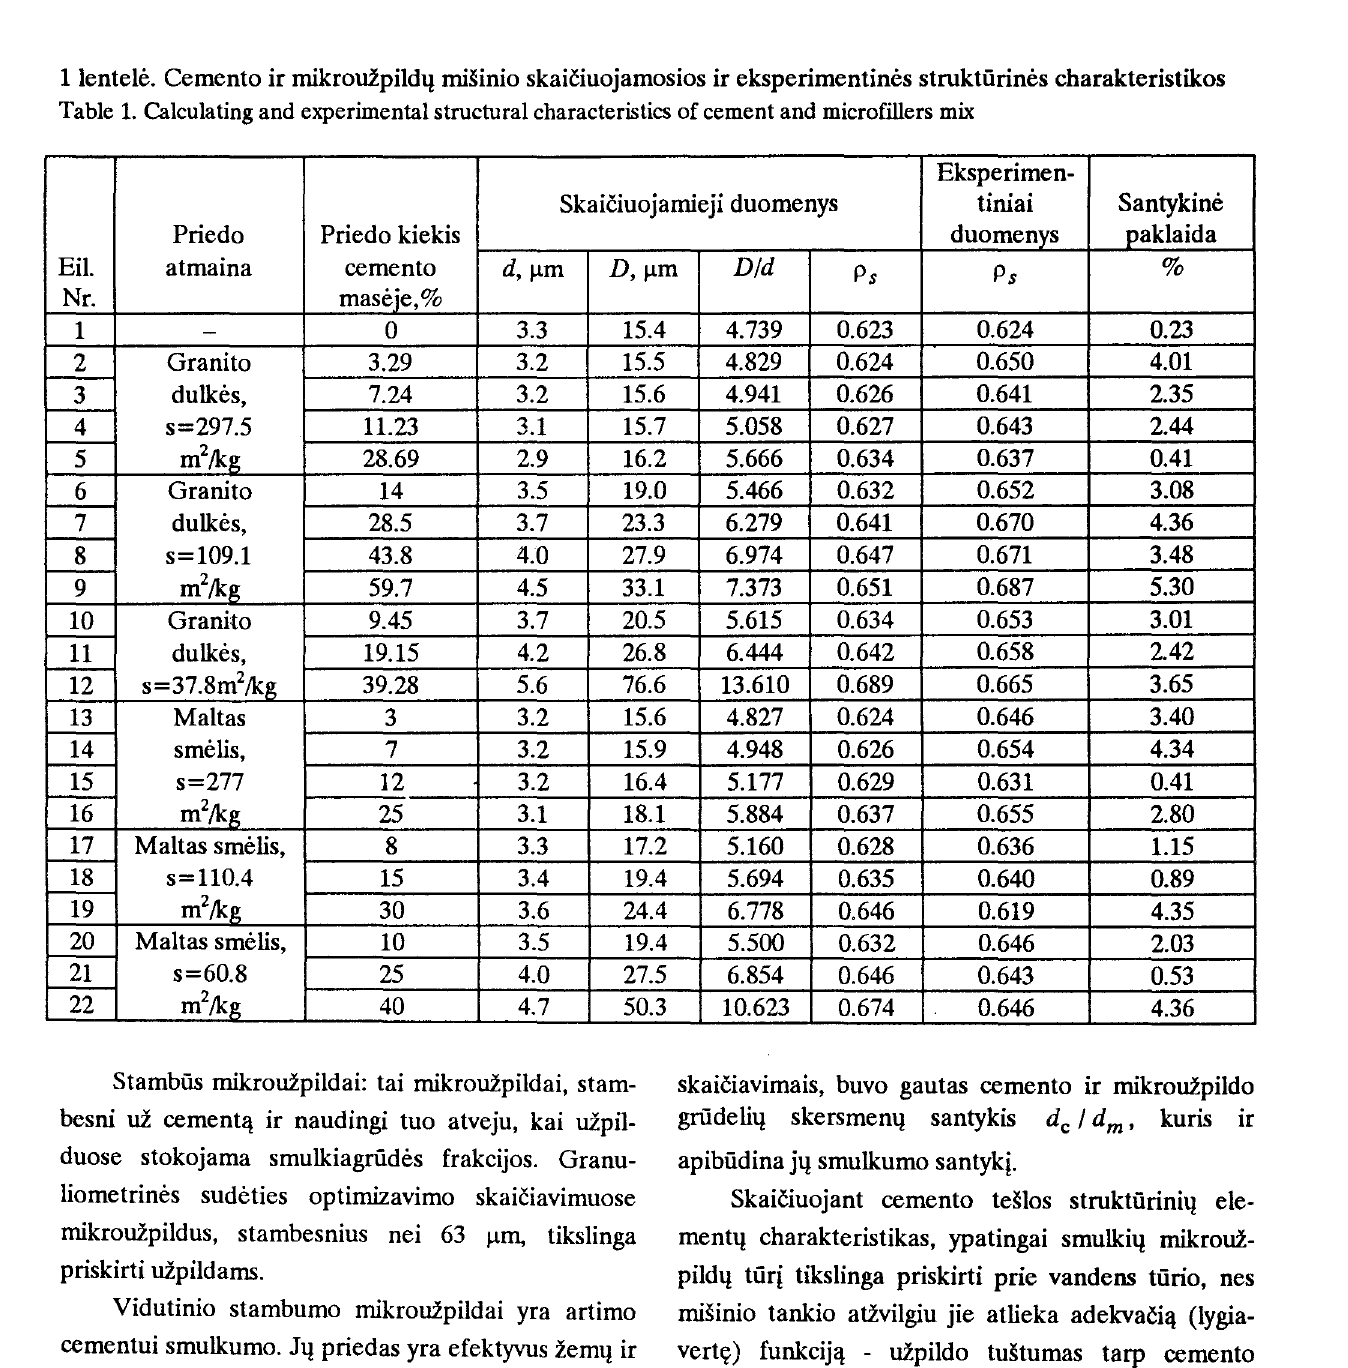
priskirti uipildams.